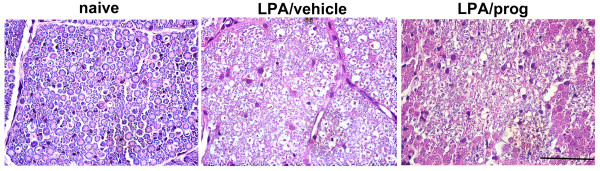
The morphological changes in the trigeminal nerve root following treatment of progesterone. Luxol fast blue stained light micrographs reveal the attenuation of demyelination of axonal portion of the trigeminal nerve root compared with vehicle-injected root after daily treatment of progesterone (16 mg/kg/day). Scale bar, 50 μm.